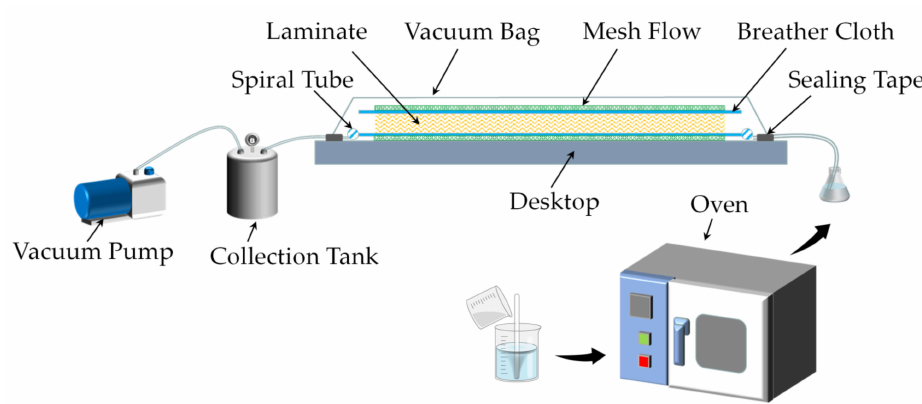
Figure 2. Flow chart of the vacuum-assisted forming